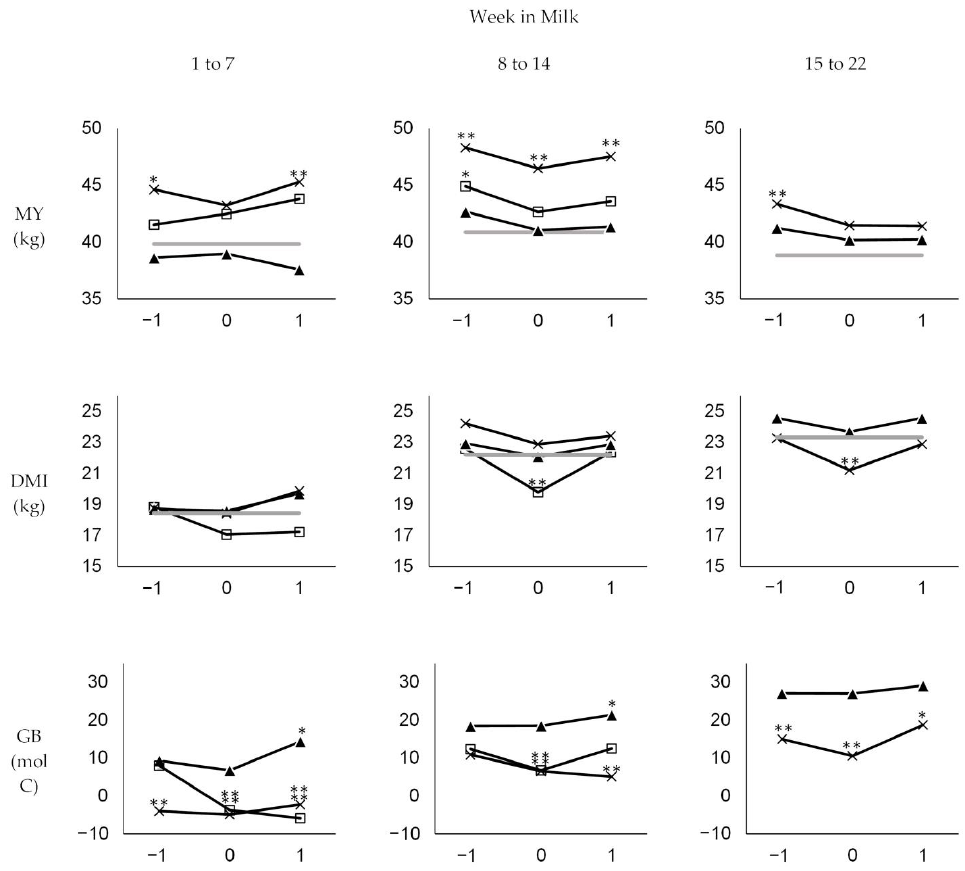
Figure 1. Weekly means of daily milk yield (MY), dry matter intake (DMI), and glucose balance (GB) in the week before ( − 1), the week of (0), and the week after (1) diagnosis in different stages of early lactation (weeks 1 to 7, 8 to 14, and 15 to 22) for different disease categories: claw and leg disease (x), mastitis ( (cid:78) ), and other diseases ( (cid:3) ). Significant differences between means in the respective week compared to the means in healthy weeks of the respective stage (grey line) are indicated at p < 0.1 (*) and p < 0.05